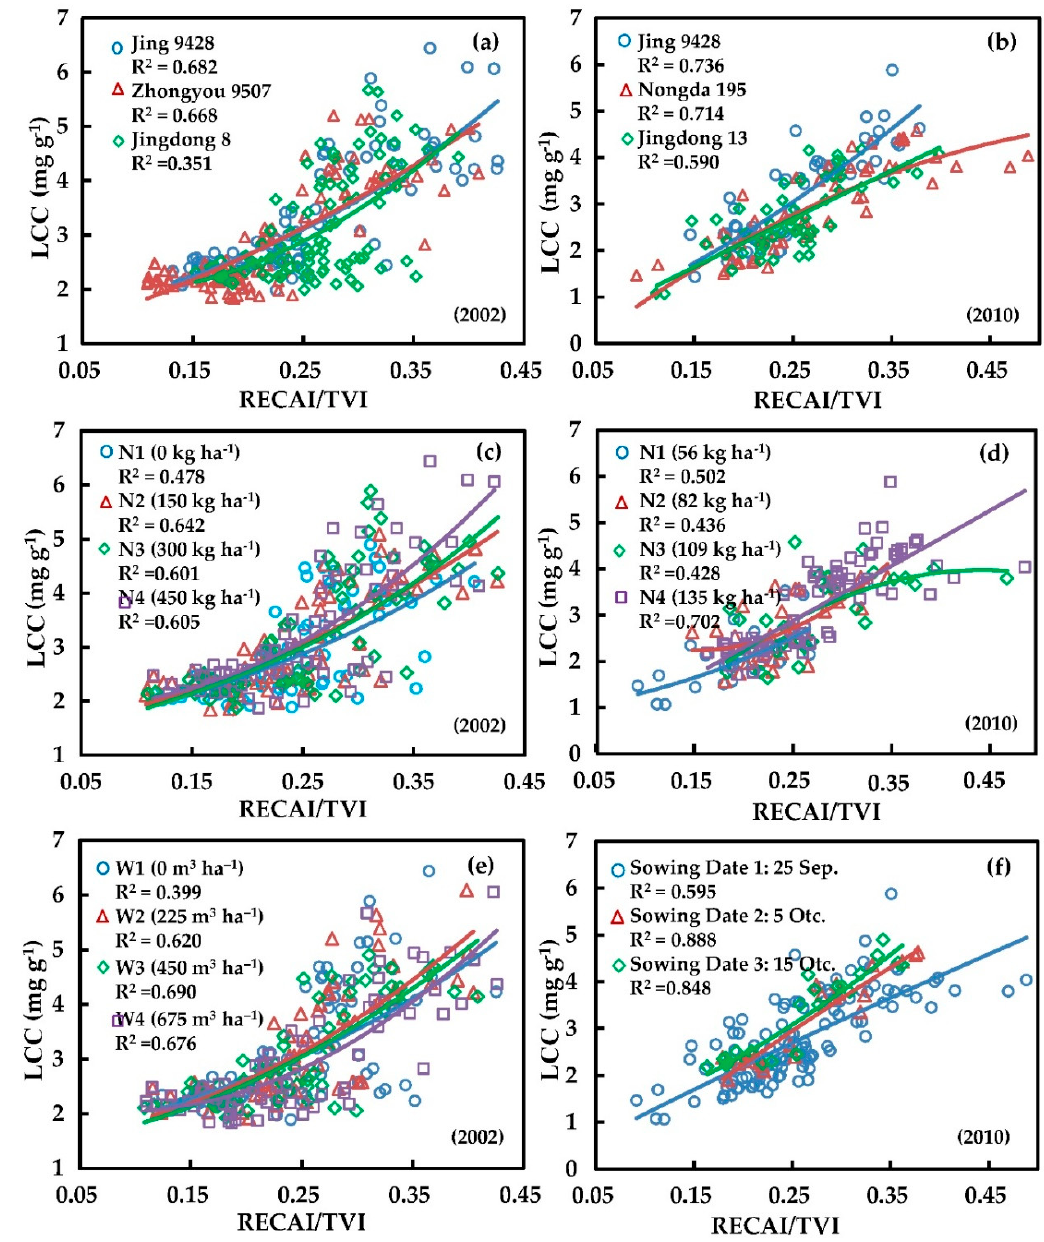
Figure 5. Influence of di ff erent field management measures on RECAI / TVI. ( a ), ( b ), ( c ), ( d ), ( e ), ( f ) stand for the scatter plots between RECAI / TVI and LCC under di ff erent crop varieties (2002), crop varieties (2010), nitrogen fertilization densities (2002), nitrogen fertilization densities (2010), water treatments, and bowing date treatments, respectively.